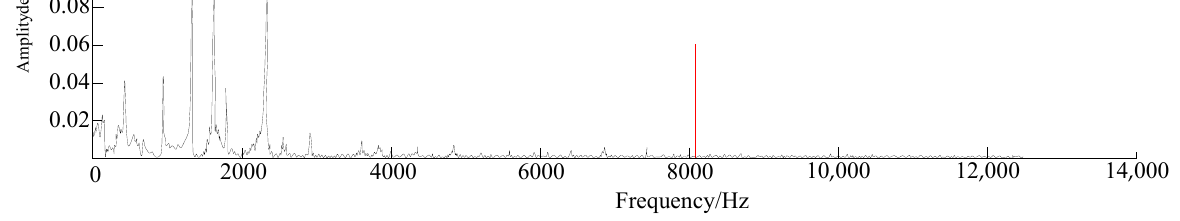
Figure 5. Corn kernel impacting signal spectrum analysis diagram.